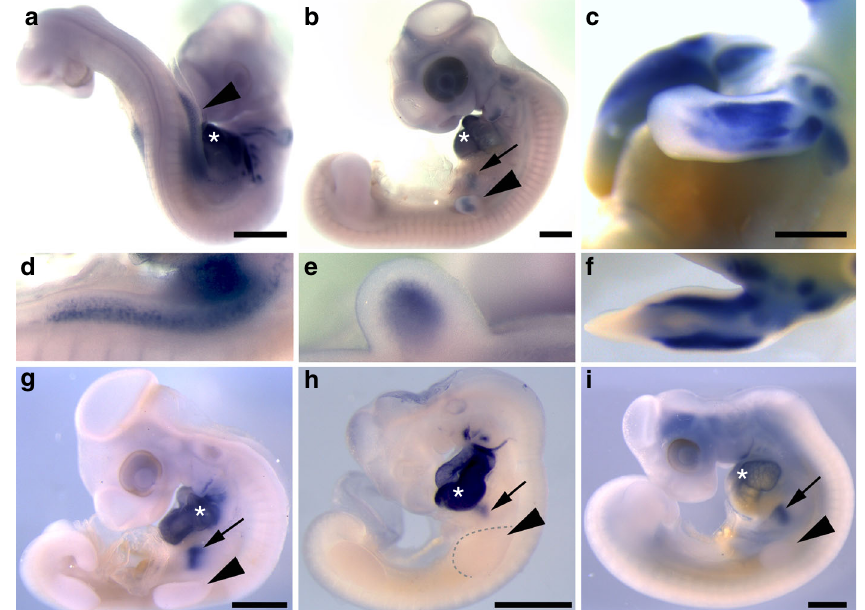
Fig. 2 In situ hybridization analysis of Nkx2.5 expression in avian embryos. Nkx2.5 is expressed in the emu forelimb bud. a – f Time course of Nkx2.5 expression in emu. a , d HH20; b , e HH25; c , f HH30; g chick HH22; h zebra fi nch HH22; i ostrich HH22. Images are representative of two or more embryos at each stage. Arrowhead , forelimb bud; arrow , stomach; asterisk , heart. Scale bar = 1